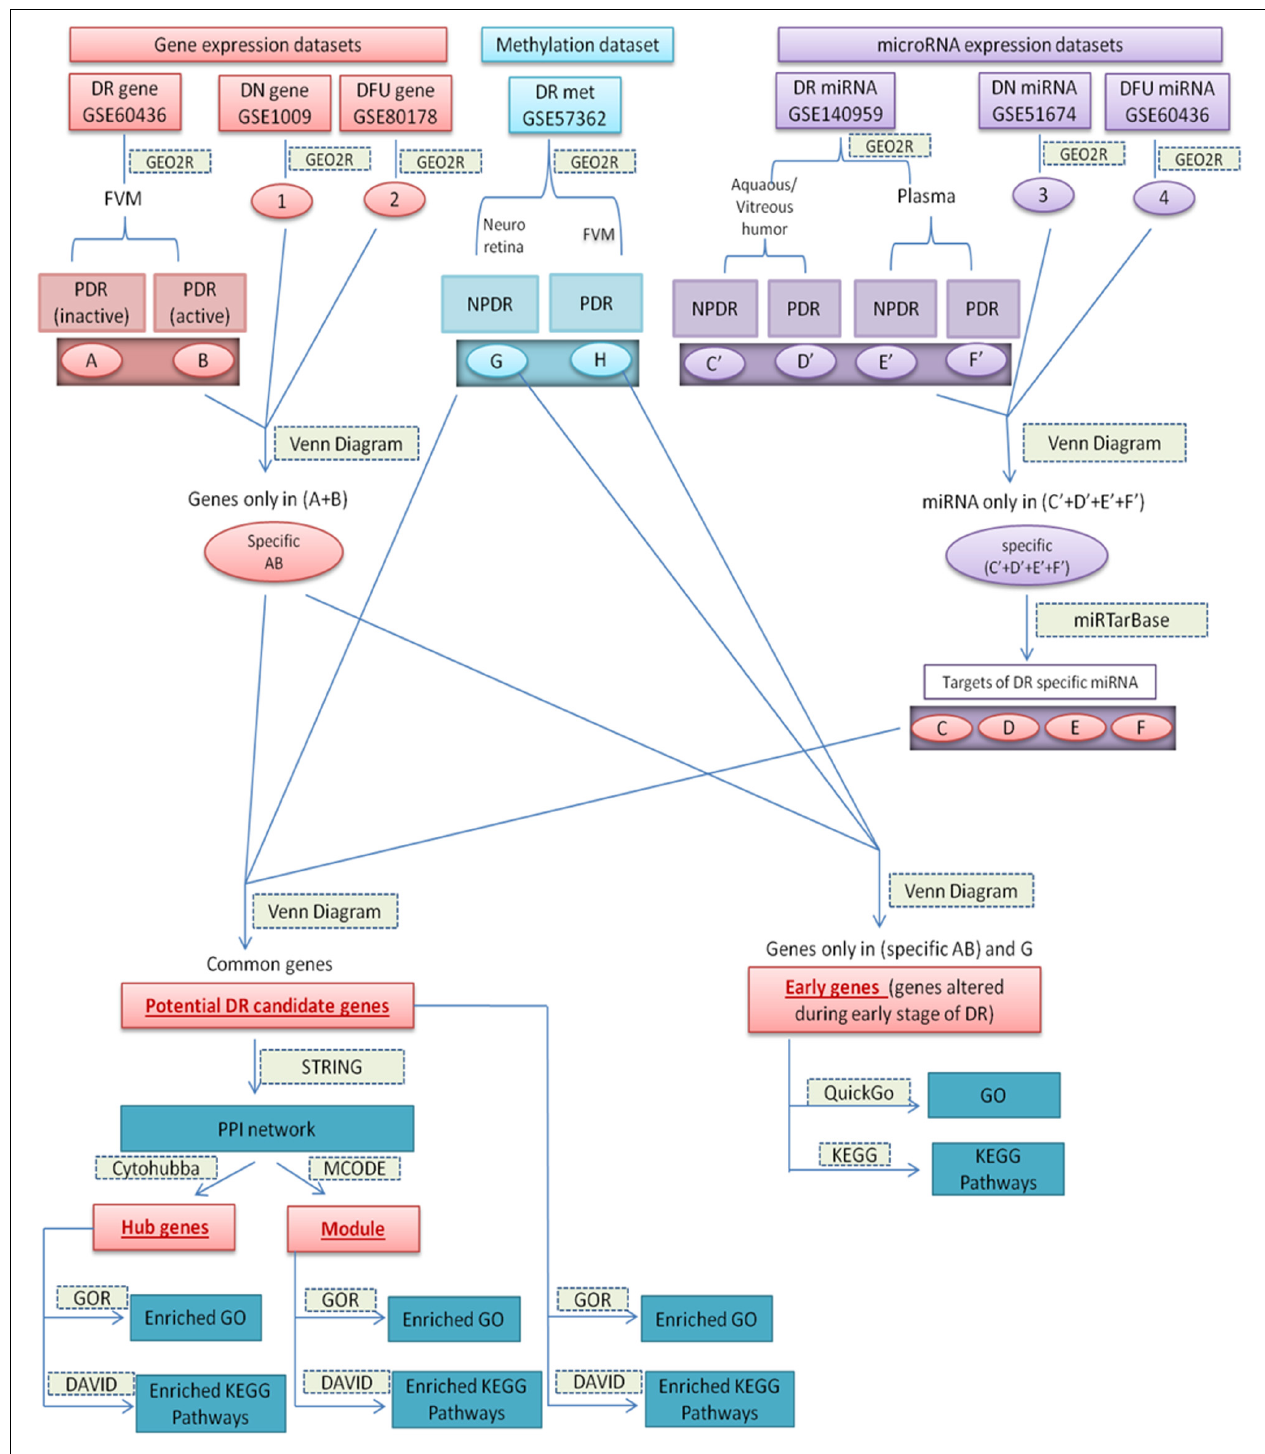
FIGURE 1 | Diagrammatic representation of overall work-flow. (A) : (DEGs in inactive FVM of PDR); (B) : (DEGs in active FVM of PDR); (G) : (DMGs in neuroretina of NPDR); (H) : (DMGs in FVM of PDR); (1) : (DEGs in glomeruli of DN kidney); (2) : (DEGs in DFU); (3) : (differentially expressed miRNAs in kidney tissue of DN); (4) : (differentially expressed miRNAs in foot fibroblast sample of DFU); (C’) : (differentially expressed miRNAs in Aqueous and vitreous humor of NPDR); (D’) : (differentially expressed miRNAs in Aqueous and vitreous humor of PDR); (E’) : (differentially expressed miRNAs in plasma of NPDR); (F’) : (differentially expressed miRNAs in plasma of PDR); (Specific AB) : (DEGs specific for DR); (Specific C’–F’) : (differentially expressed miRNAs specific for DR); (C–F) : (targets of DR specific differentially expressed miRNA).